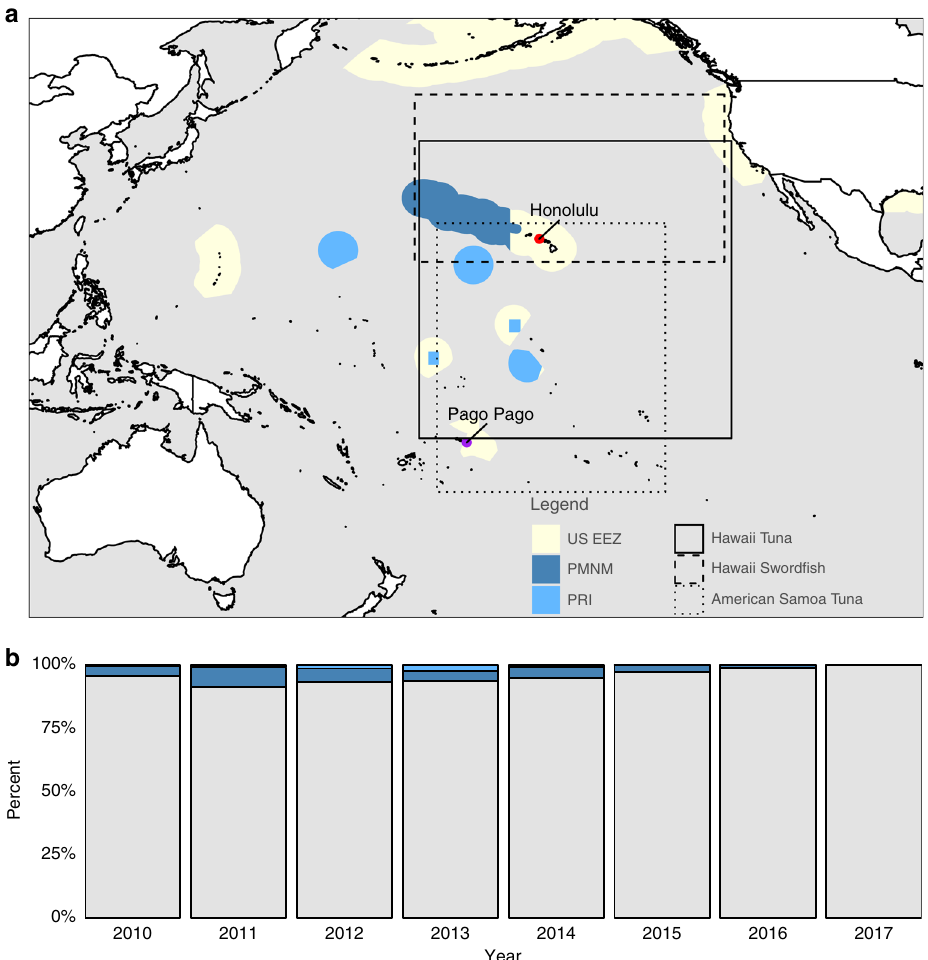
Fig. 1 Map of the Marine National Monuments and fi shing locations by year. In panel a , dark blue indicates Papah a naumoku a kea Marine National Monument (PMNM), light blue indicates the Paci fi c Remote Islands Marine National Monument (PRI), and light yellow indicates the U.S. exclusive economic zone (EEZ). The three rectangles represent the maximum spatial extent of the three fi shing fl eets analyzed, based on observer data: solid black for the Hawaii Tuna fl eet, long dashes for the Hawaii Sword fi sh fl eet, and short dashes for the American Samoa Tuna fl eet. The northern boundaries of the rectangles are based on the furthest north set, the eastern boundaries are based on the furthest east set, etc. Thus, the vertices of the rectangles do not necessarily indicate the location of a fi shing set. The locations of the two main fi shing ports for the fl eets analyzed are also displayed. Panel b shows the percentage of fi shing sets by year for the Hawaii-based tuna fl eet that start inside the Paci fi c Remote Islands Marine National Monument (light blue), inside the Papah a naumoku a kea Marine National Monument (dark blue), or outside the monuments